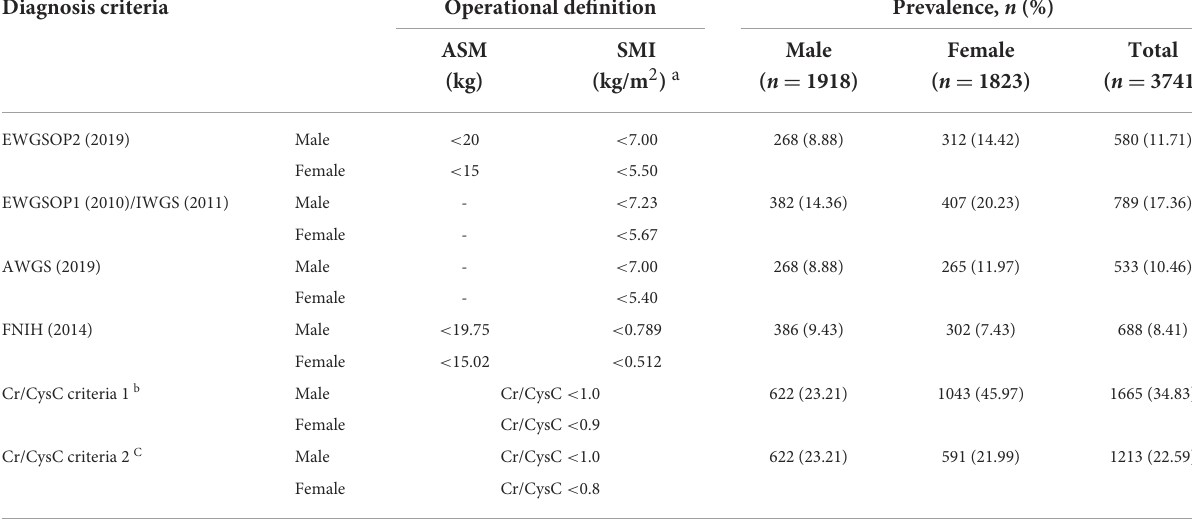
TABLE 2 Summary of operational definition and prevalence (weighted) for low muscle mass by sex.